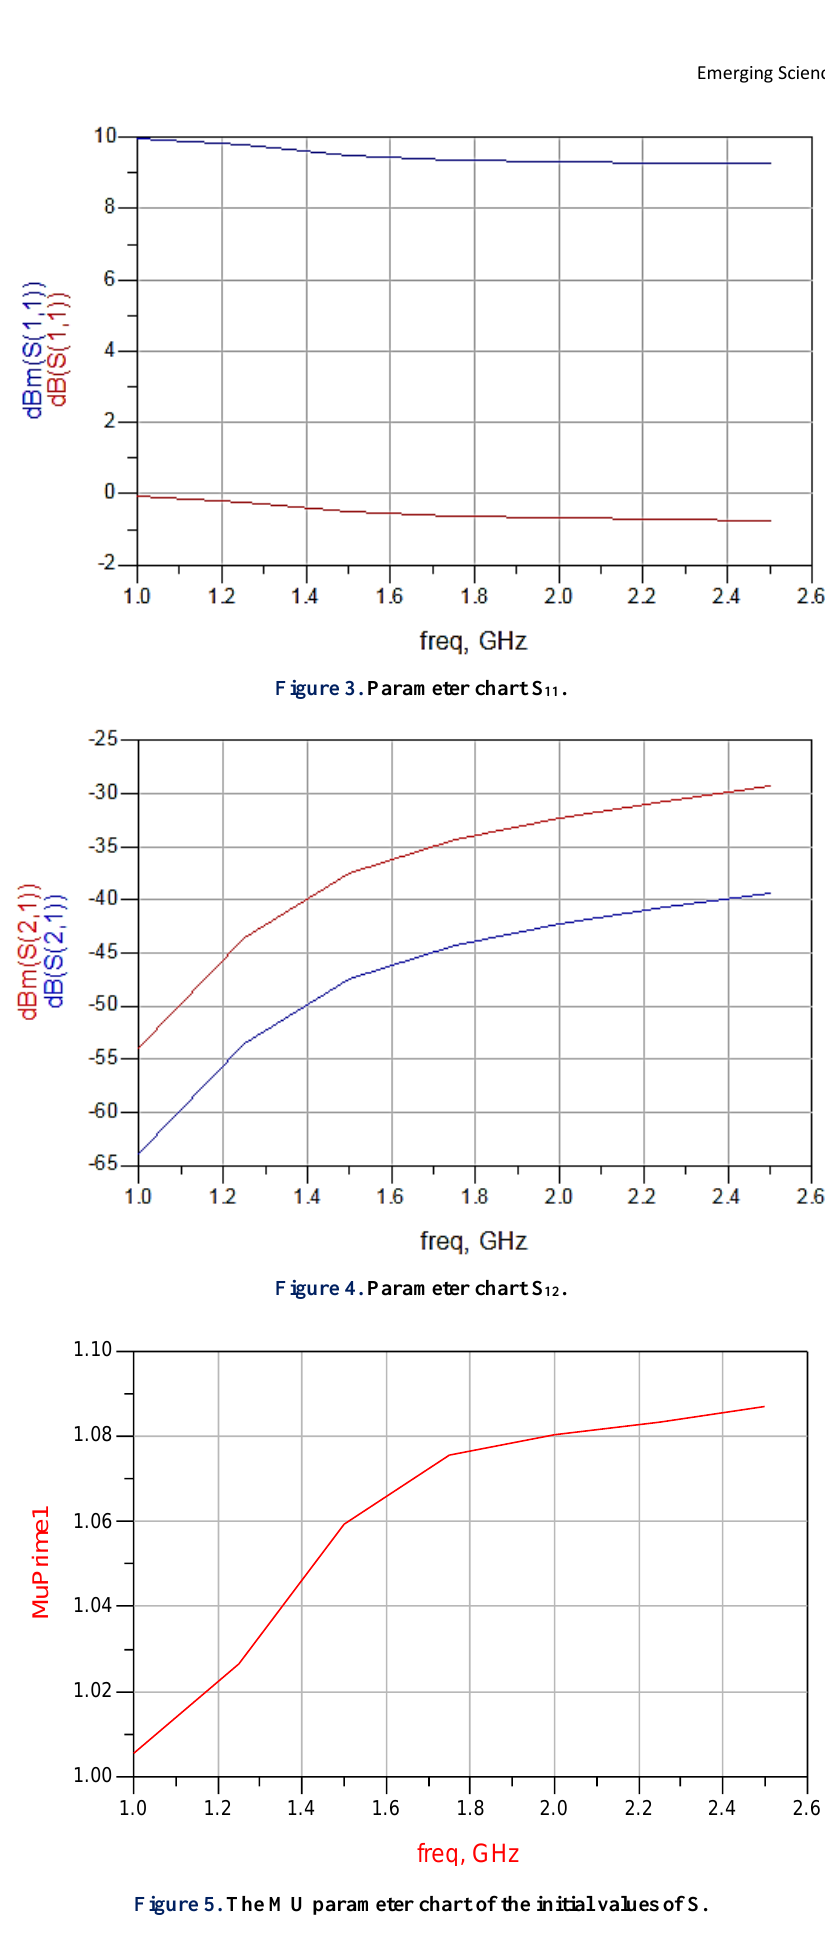
Figure 5. The MU parameter chart of the initial values of